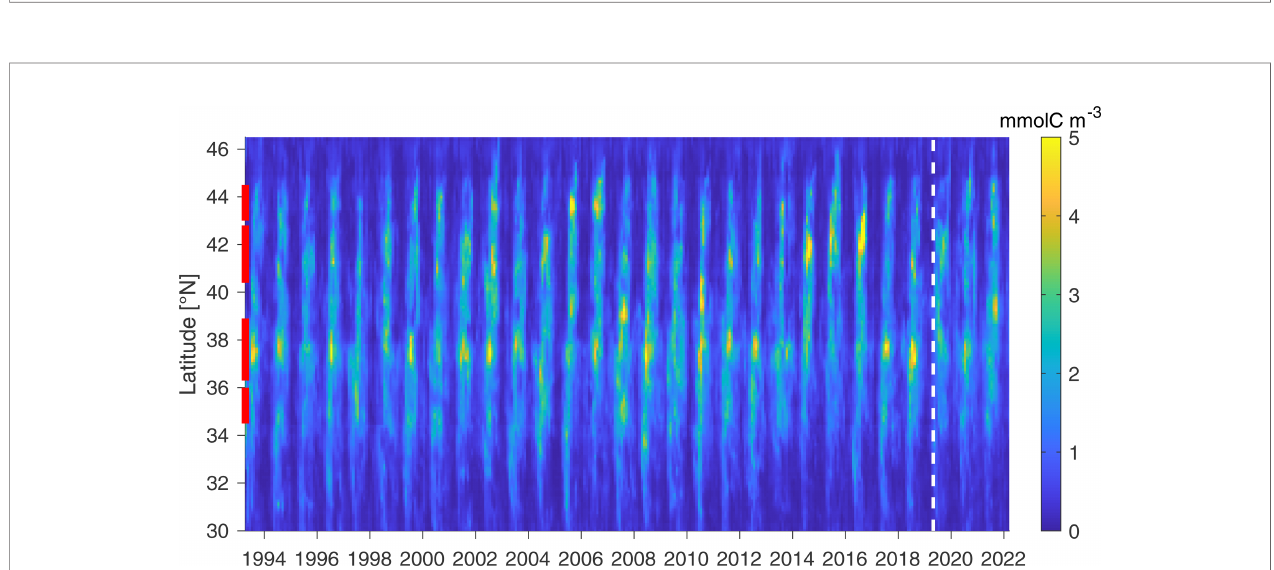
FIGURE 8 | Krill temporal variability: Z big averaged in a 150 km coastal band (GA-sat, monthly 1/8° resolution). The white dashed line indicates when Z big became based on NRT satellite